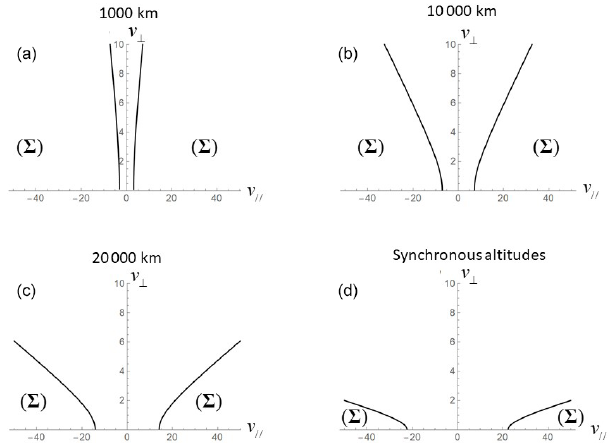
Figure 2. Regions of velocity space ( (cid:54) ) occupied by the iono- spheric species are shown. They were accelerated by the parallel potentials and magnetic mirror force: (a) electrons (ions) at 1000km altitudes for parallel potentials of 10V ( − 10V), (b) electrons (ions) at 10000km for 50V ( − 50V), (c) electrons (ions) at 20000km for 200V ( − 200V), and (d) electrons (ions) at geosynchronous alti- tudes for 500V ( − 500V). In the velocity space, ( v // , v ⊥ ) is nor- malized by the thermal velocity of respective particles (1eV for this